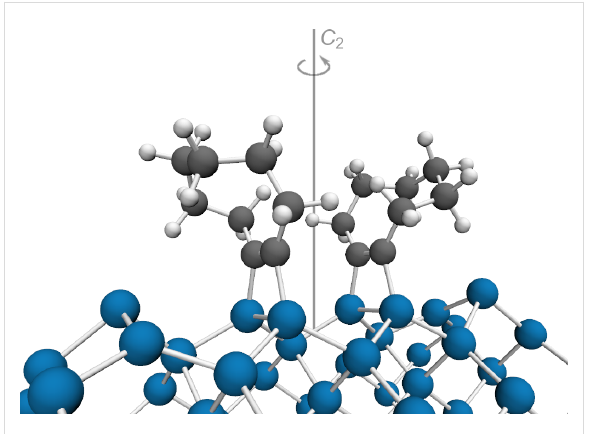
Figure 2: Optimized (PBE-D3/PAW) structure of two molecules of 1 on Si(001) on neighbouring surface dimers ( 3 ).